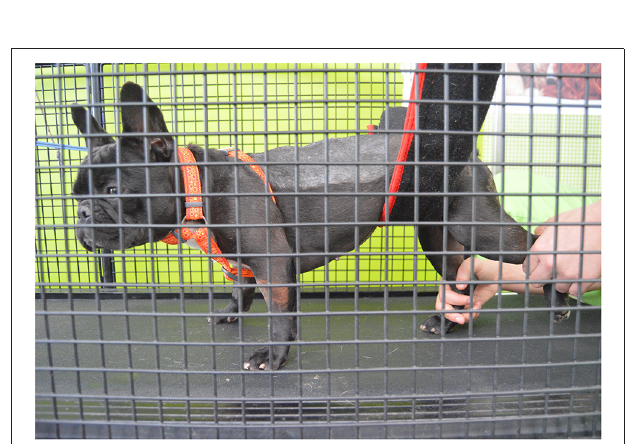
FIGURE 6 | Body weight -supported treadmill training with quadrupedal step training. Technician preforming bicycle movements.